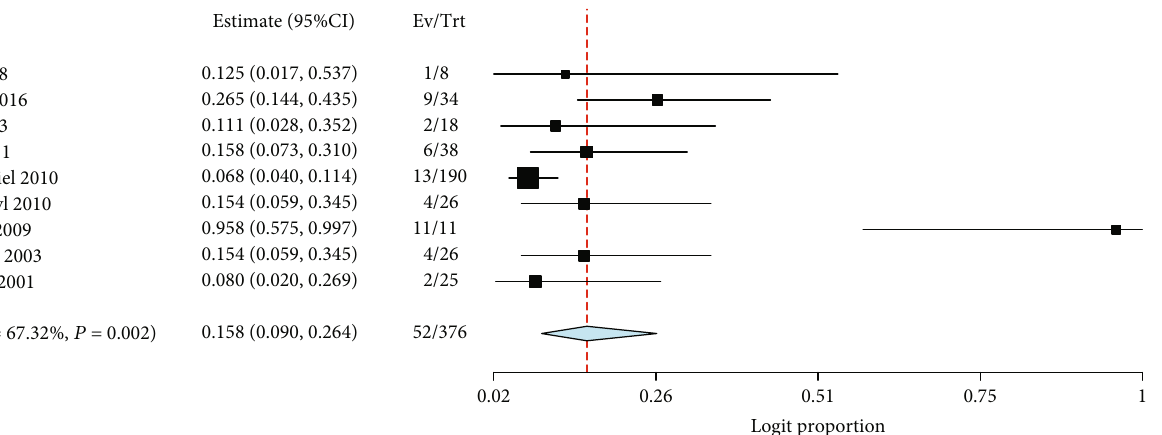
Figure 3: Forest plots of OR rate after PDT.